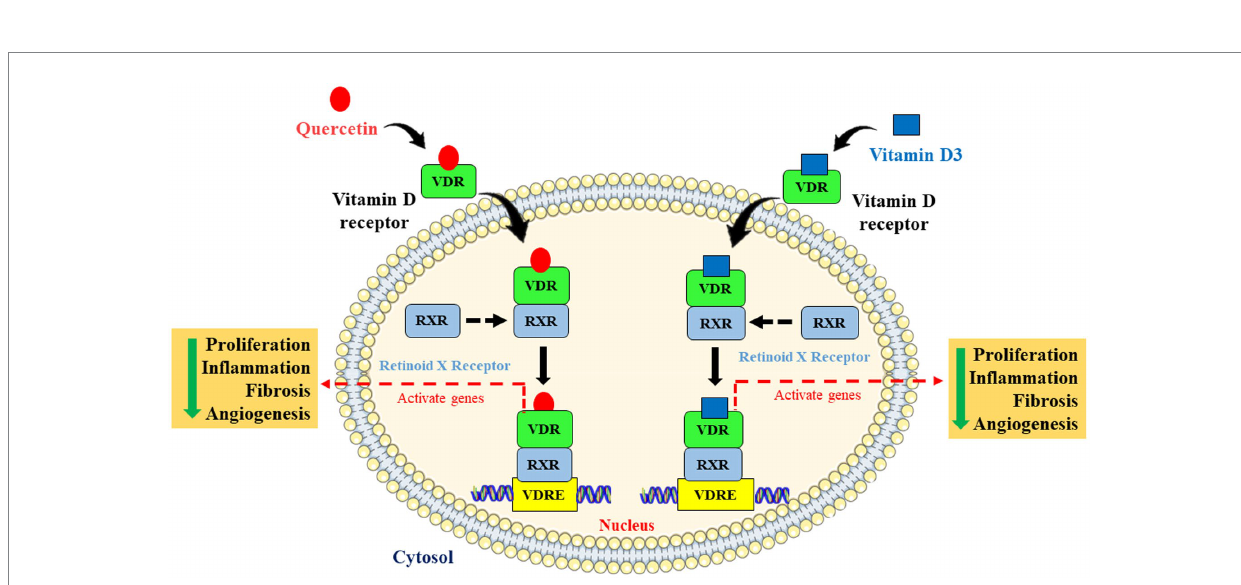
FIGURE 8 Schematic representation and molecular mechanism of quercetin mimicking the role of vitamin D via vitamin D receptor. Quercetin mimics vitamin D through activating the vitamin D receptor by forming dimers with retinoid X receptor and is involved in the inhibition of cell proliferation, angiogenesis, inflammation, and fibrosis via activating Vitamin D response elements